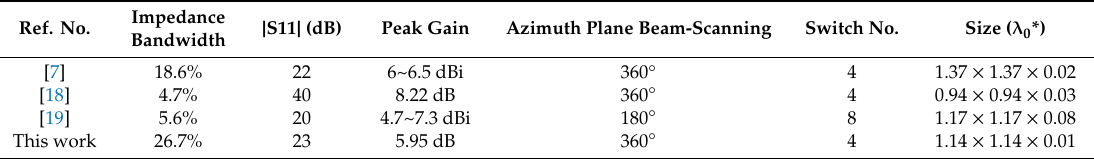
Table 3. Comparison between recently proposed antennas and the proposed wideband reconfigurable